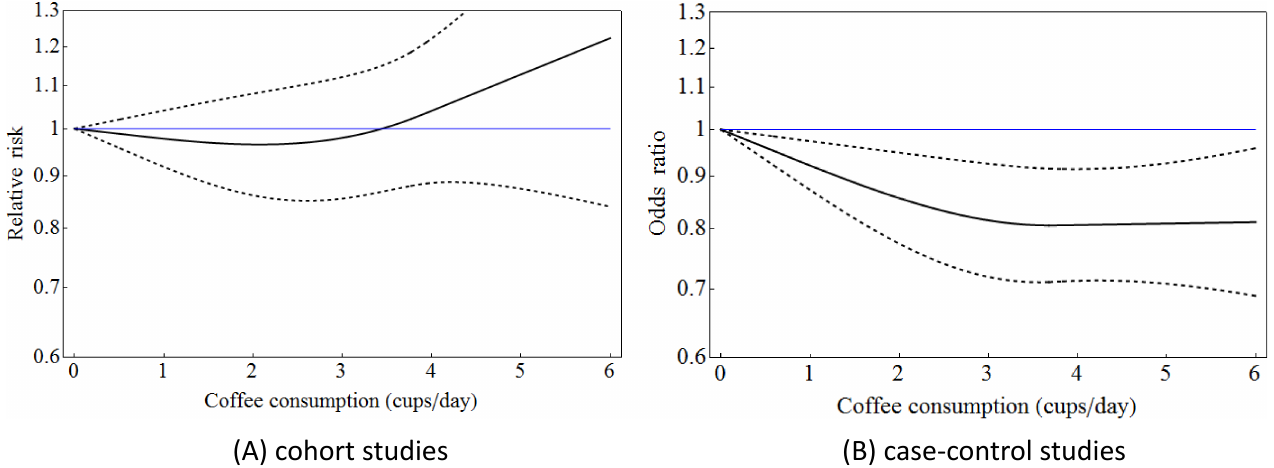
Figure 1. Dose-response curves of colorectal cancer risk associated with co ff ee consumption among the Japanese population, in a meta-analysis including cohort studies (A) and case-control studies (B). Dashed curves represent 95% con fi dence intervals for each value of co ff ee consumption.